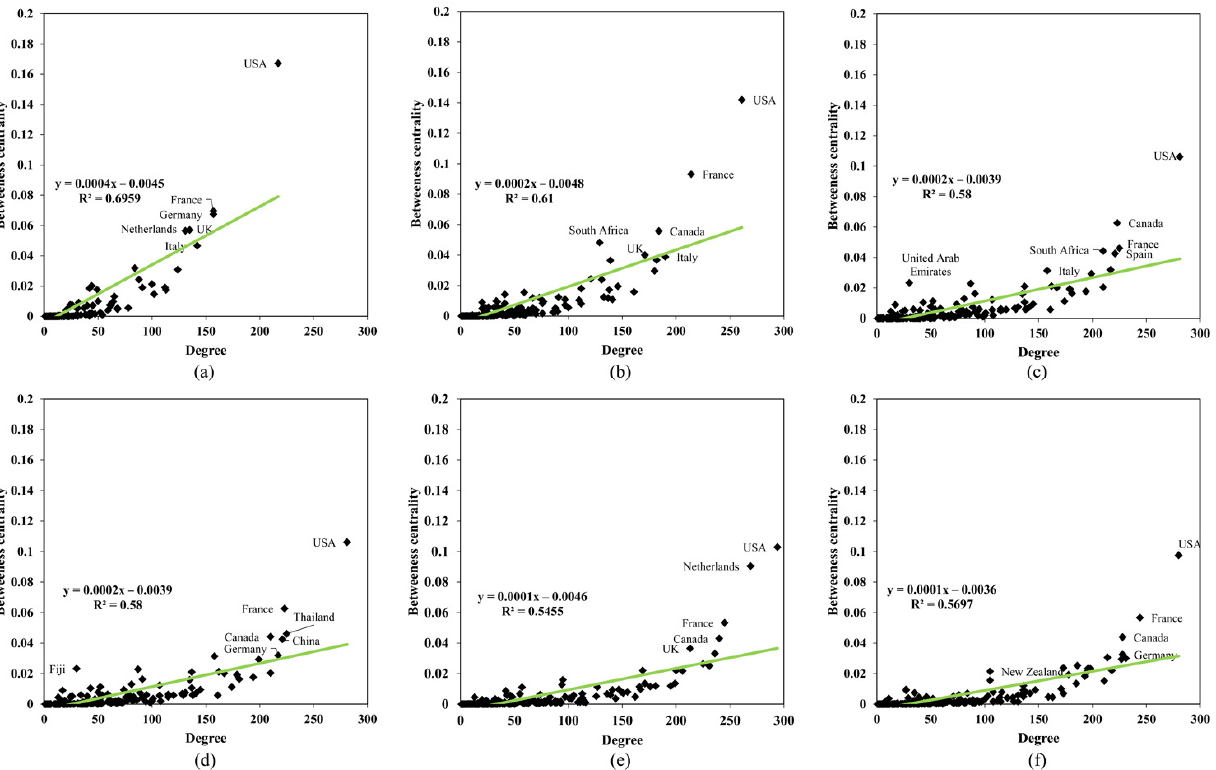
Figure 8. Scatter plots depicting the number of partners versus intermediary centrality (the horizontal axis represents the number of agricultural trade partners of a country, the vertical axis represents the intermediary centrality of a country, and the green line is the fitted regression line). ( a ) represents the scatter plot of 1996, ( b ) represents the scatter plot of 2000, ( c ) represents the scatter plot of 2005, ( d ) represents the scatter plot of 2010, ( e ) represents the scatter plot of 2015, and ( f ) represents the scatter plot of 2019.